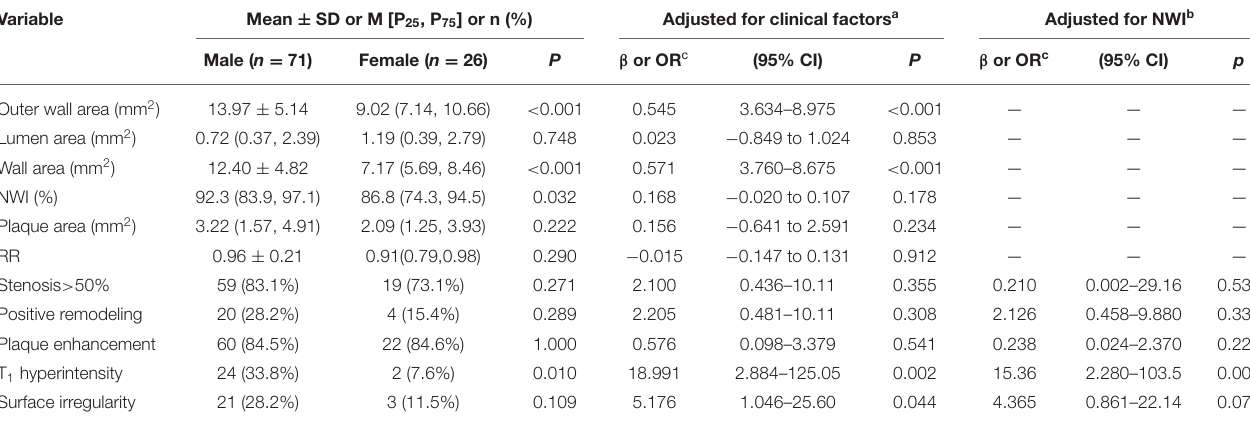
TABLE 3 | Univariate comparison and multivariate regression models of gender differences in Culprit plaque characteristics. Variable